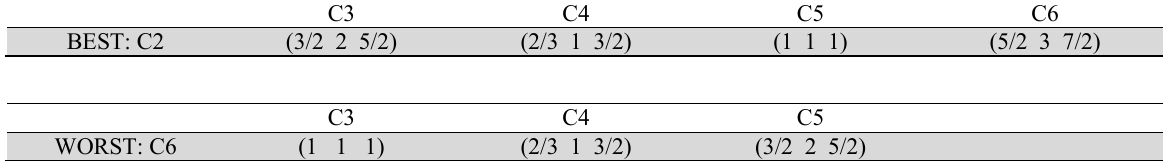
Pair-wise comparisons of criteria with the best and the worst criteria based on C1 C3 C4